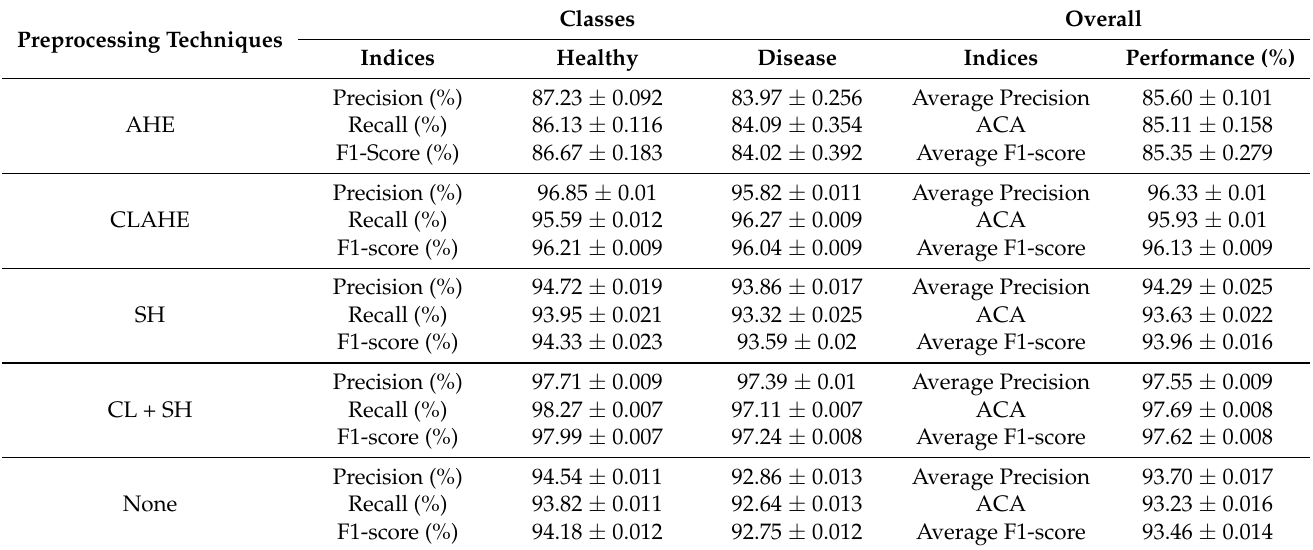
Table 4. ResNet-50 classification with GAN-based on different preprocessing techniques Preprocessing Techniques